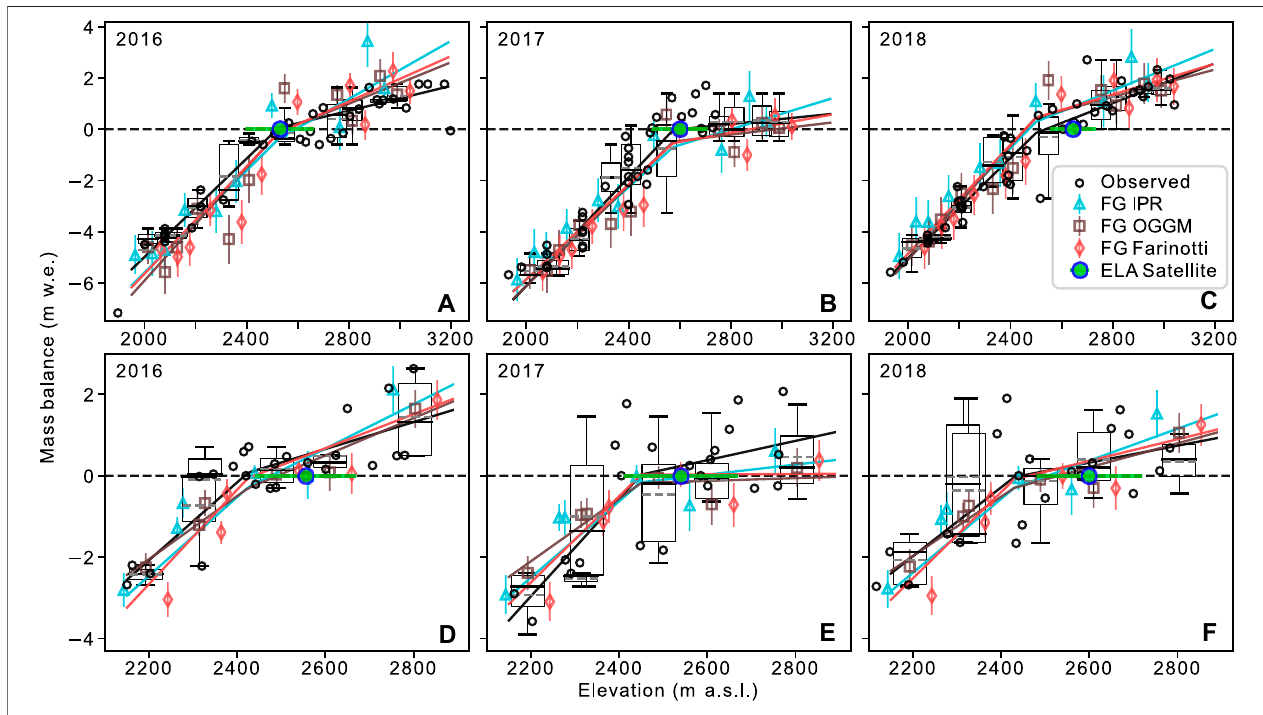
FIGURE9| Observedandmodeled( fl uxgate,FG) b a forConrad (A – C) ,and Nordic (D – F) glaciersfor2016,2017and 2018.Dataarethesameasin Figure8 ,but balance gradients are fi t with piecewise linear functions. Boxplots represent glaciological b a observations for each fl ux bin with 95% con fi dence interval (whiskers), IQR range (box), median (black line) and mean (dashed grey line). Colored error bars represent modeled b a for each fl ux